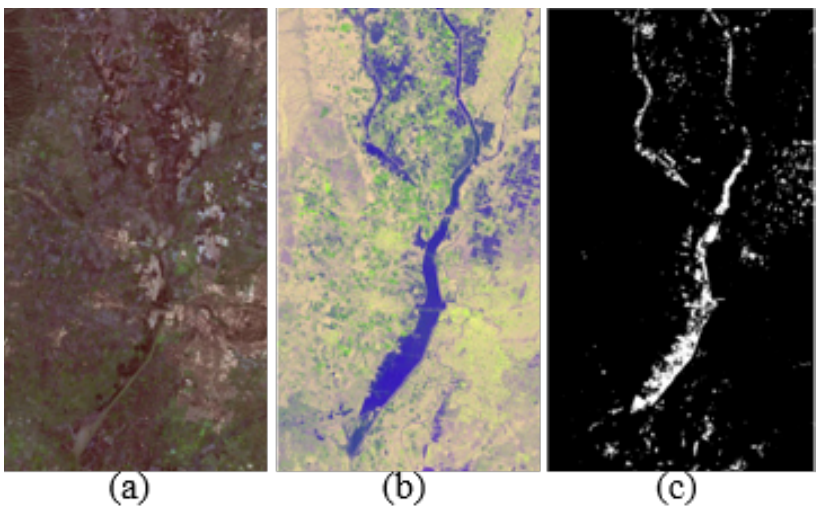
Figure 4. California dataset. ( a ) Landsat-8 optical image. ( b ) Sentinel-1A SAR image. ( c ) Ground-truth.